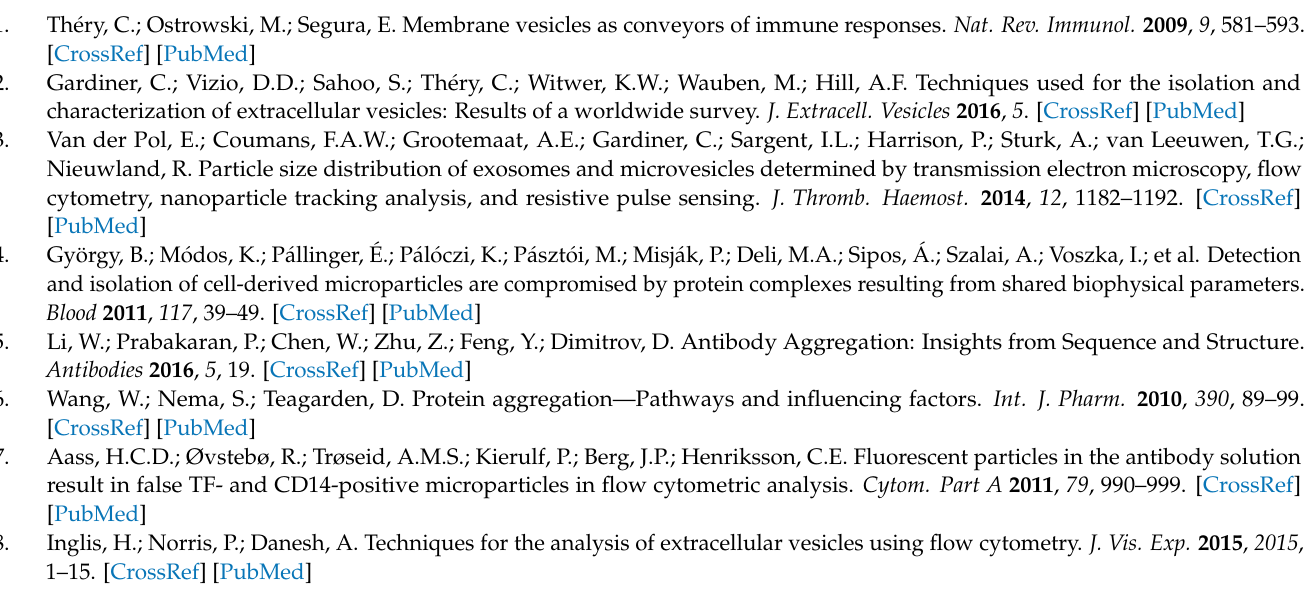
Figure S5: P1 specific labels, Figure S6: P1 isotype labels, Figure S7: P2 specific labels, Figure S8: P2 isotype labels, Table S2 Reduction (panels), Table S3: figure explanation for Figure 5, Figure S9: Scatterplot representation for the study presented in Figure 5, Table S4: reduction of individual labels for all treatments, Table S5: Points to consider when designing a